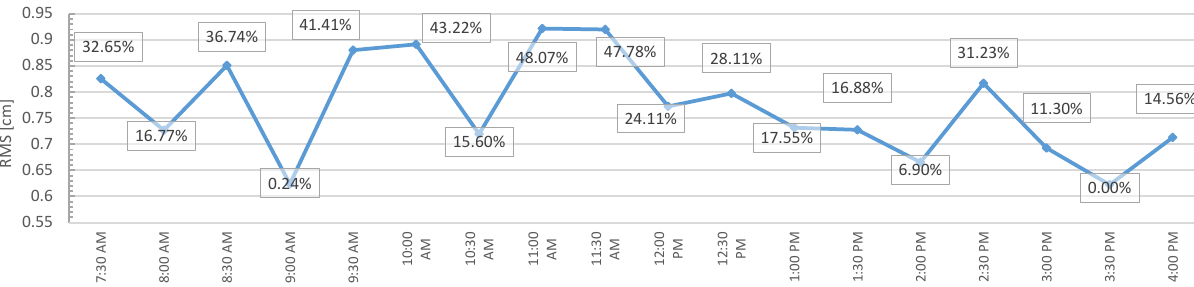
Figure 6. Assessment of repeatability by time – Virtual test site. The graph labels show the RMS % increase w.r.t. best